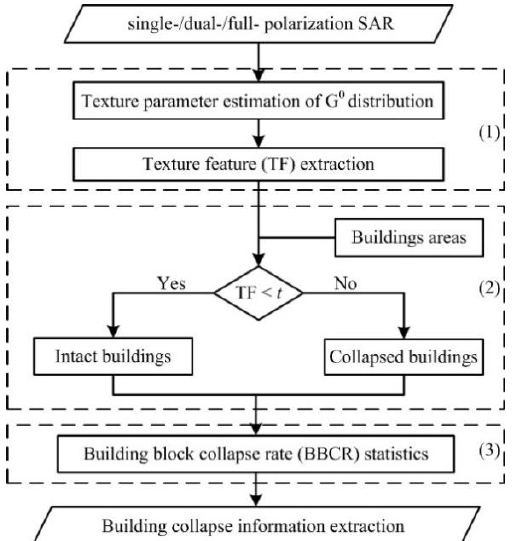
Figure 1. The flow chart of building damage